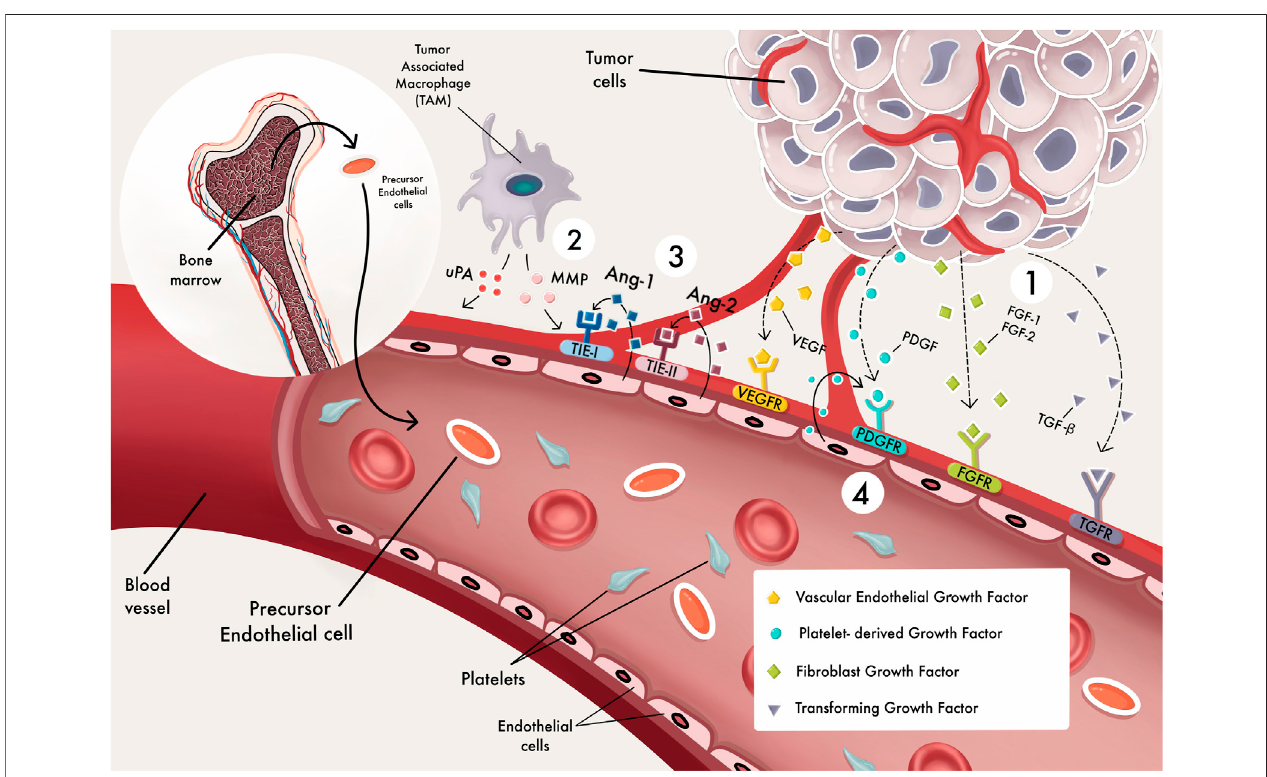
FIGURE 1 | angiogenesis processes. The different stages of blood vessel development (Siegel et al., 2021). angiogenesis factors activate signal transduction pathways by binding to endothelial cells (EC) receptors (Chaffer and Weinberg, 2011). MMPs degrade the extracellular matrix, allowing ECs to migrate and proliferate outside the pre-existing capillary wall (Folkman, 1971). Endothelial cells express Tie-2 receptors for binding with Angiopoietin-1 (Ange-l); this might promote vessel sprouting, pericyte acquisition, vessel survival, and stabilization (Leone et al., 2019). ECs secrete PDGF, which attracts pericyte precursors as a chemoattractant. These cells attach to endothelial cells and grow into